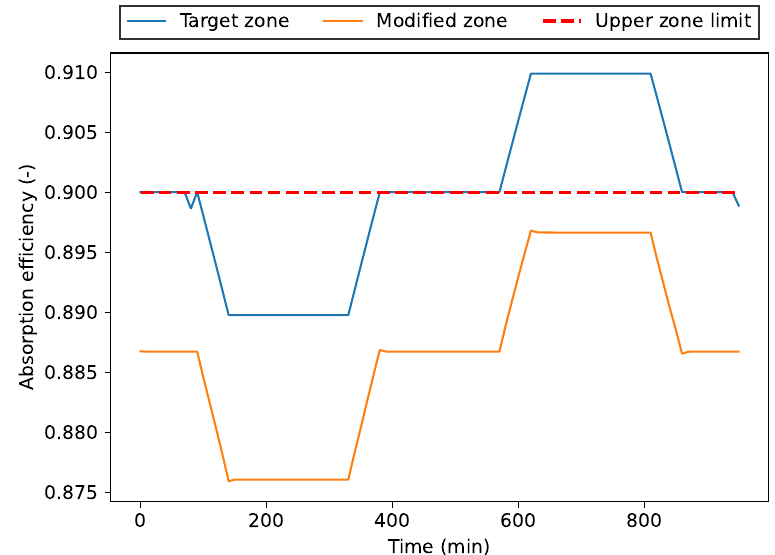
Figure 6. Trajectories of the absorption efficiency for the absorption column under the operation of the zone EMPC control algorithm tracking the original target zone (blue) and modified zone (orange) for the time-varying flue gas scenario.